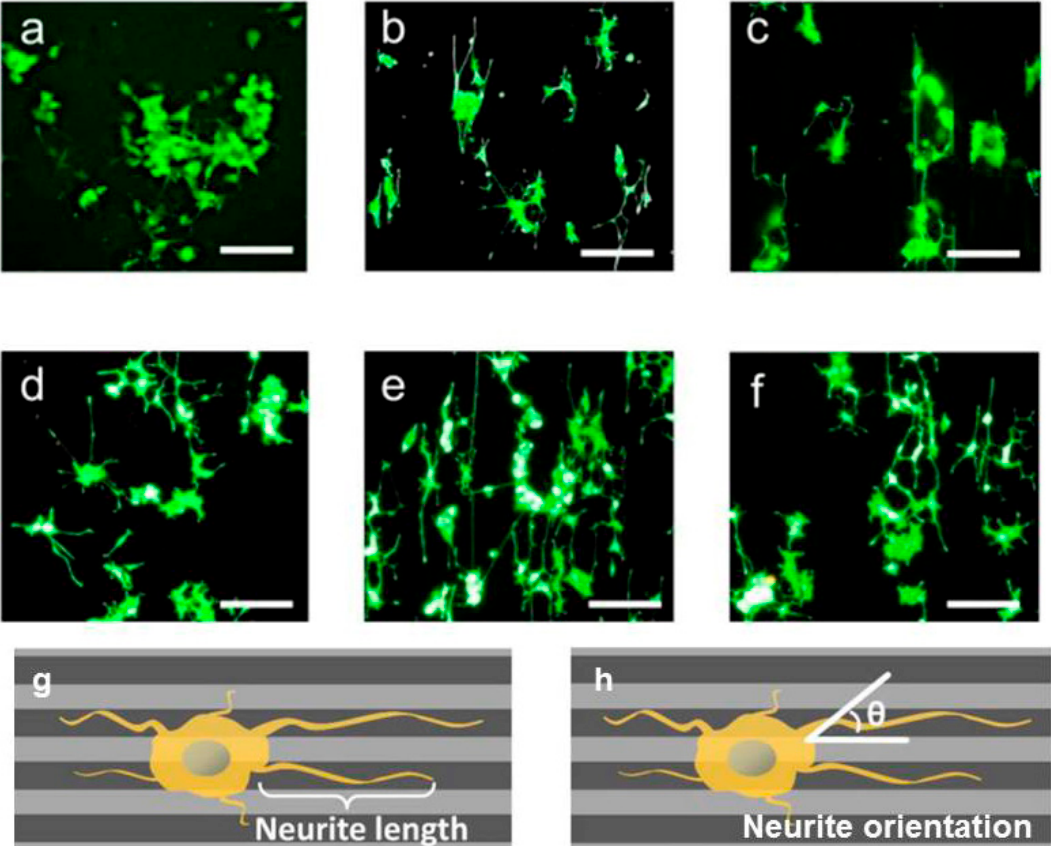
Figure 5. Culturing Schwann cell on conductive substrate affected the cell morphology and orientation. Moreover, micropatterning along with conductivity affect the cell morphology and alignment. ( a ) flat substrate, ( b ) grooved substrate 50 µm, ( c ) grooved substrate 100 µm, ( d ) flat conductive substrate, ( e ) grooved conductive substrate 50 µ m, ( f ) grooved conductive substrate 100 µ m, ( g ) schematic of neurite length, ( h ) neurite orientation [145], copyright Elsevier,